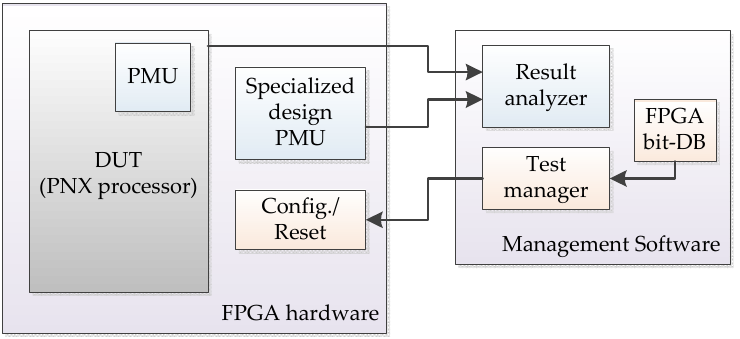
Figure 4. The conceptual block diagram of the FPGA